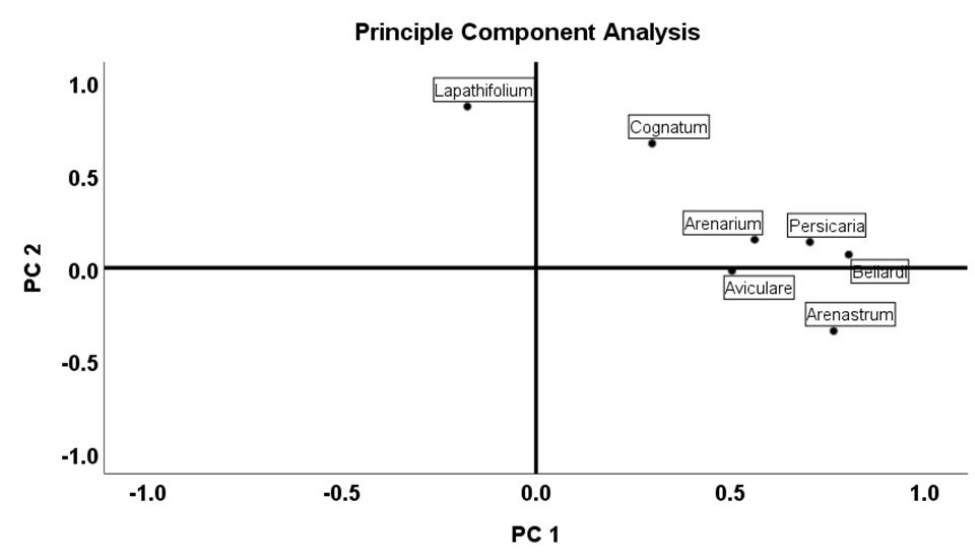
Figure 2. Principal component analysis (PCA) of the essential-oil composition of Polygonum species.